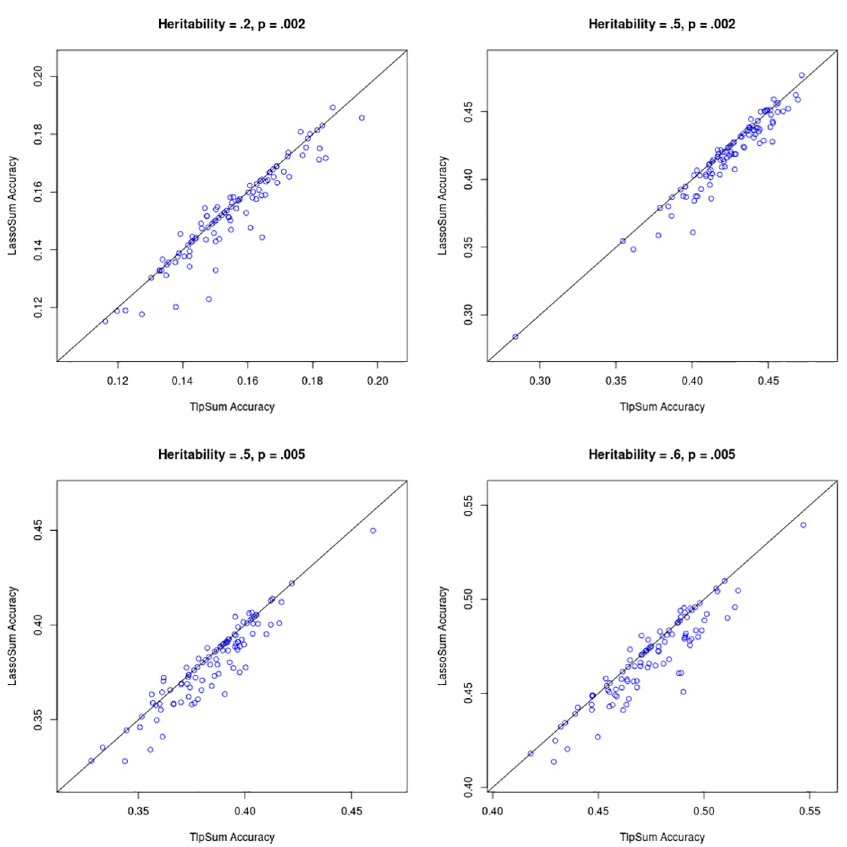
Fig 4. Predictive r 2 on out-of-sample data for TlpSum and LassoSum for each of the 100 replications at each of the four simulation settings. Lines are at a 45 degree angle through the origin, and not a line of best fit. Points below the line indicate better performance of